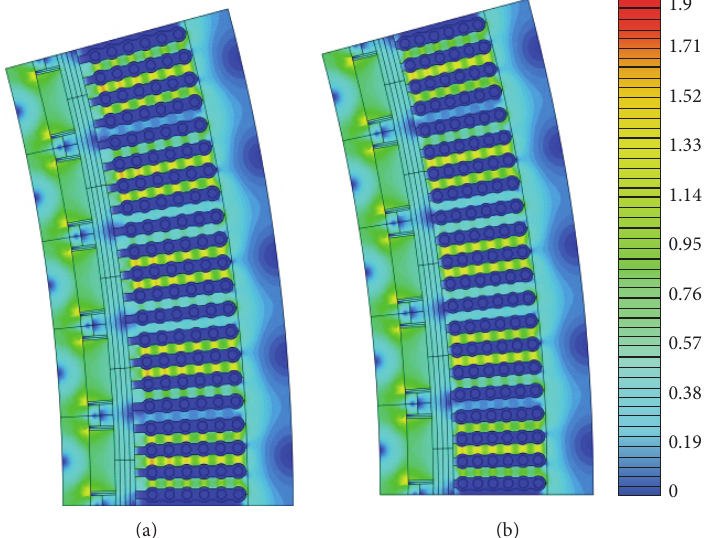
Figure 7: Illustration of the magnetic field distribution in the reference machine (to the left) and the new design (to the right).